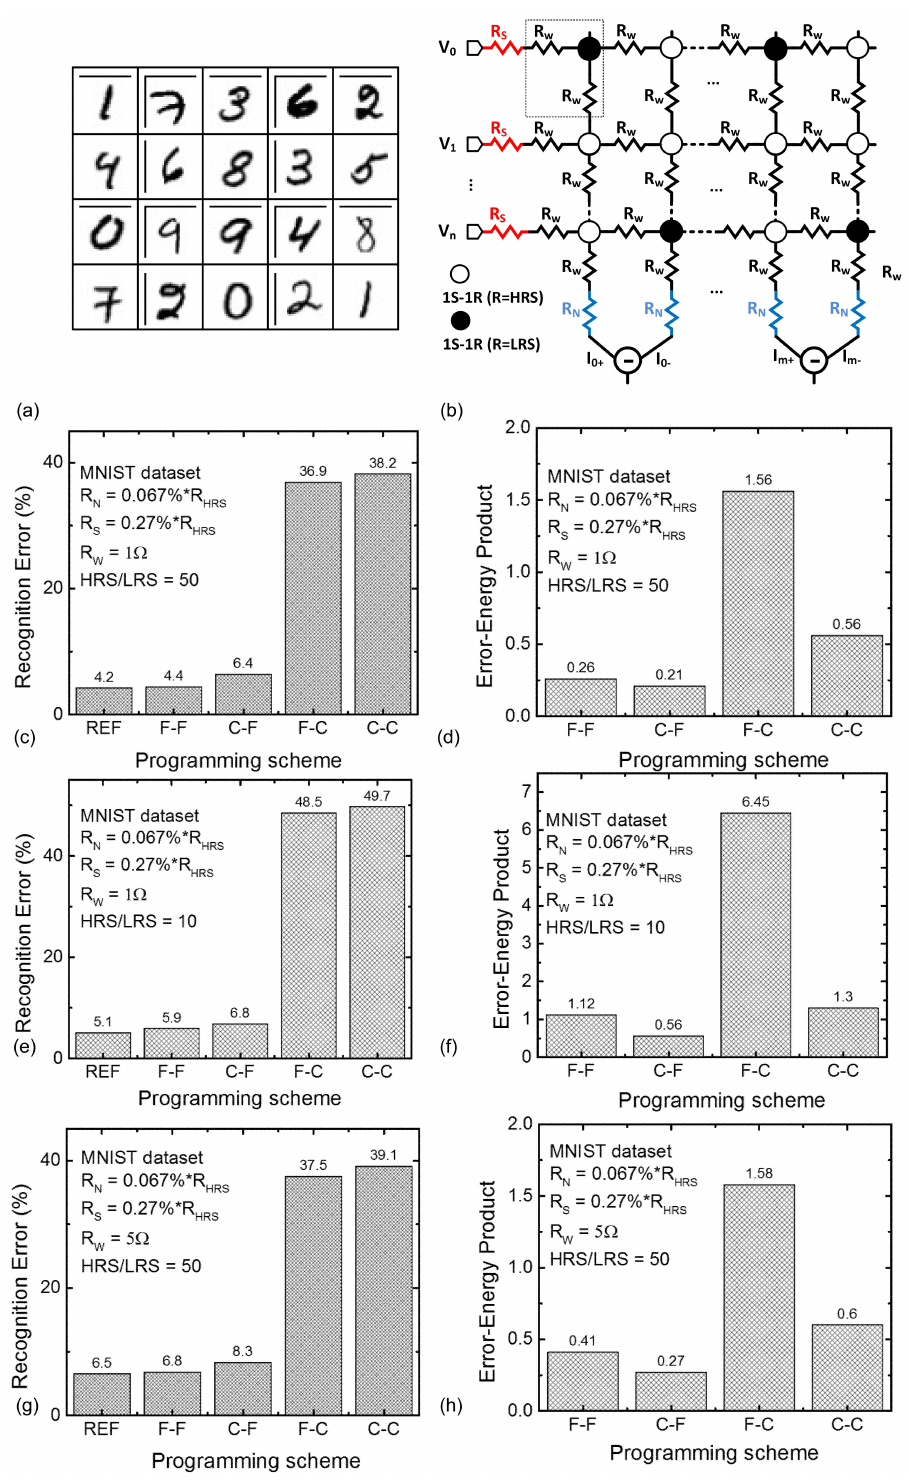
Figure 5. ( a ) The MNIST vectors. ( b ) The binary-memristor crossbar with R S , R N , and R W . ( c ) The recognition error with HRS/LRS = 50 and R W = 1 Ω . ( d ) The error-energy product with the HRS/LRS ratio = 50 and R W = 1 Ω . ( e ) The recognition error with HRS/LRS = 10 and R W = 1 Ω . ( f ) The error-energy product with HRS/LRS = 10 and R W = 1 Ω . ( g ) The recognition rate with HRS/LRS = 50 and R W = 5 Ω . ( h ) The error-energy product with HRS/LRS = 50 and R W = 5 Ω